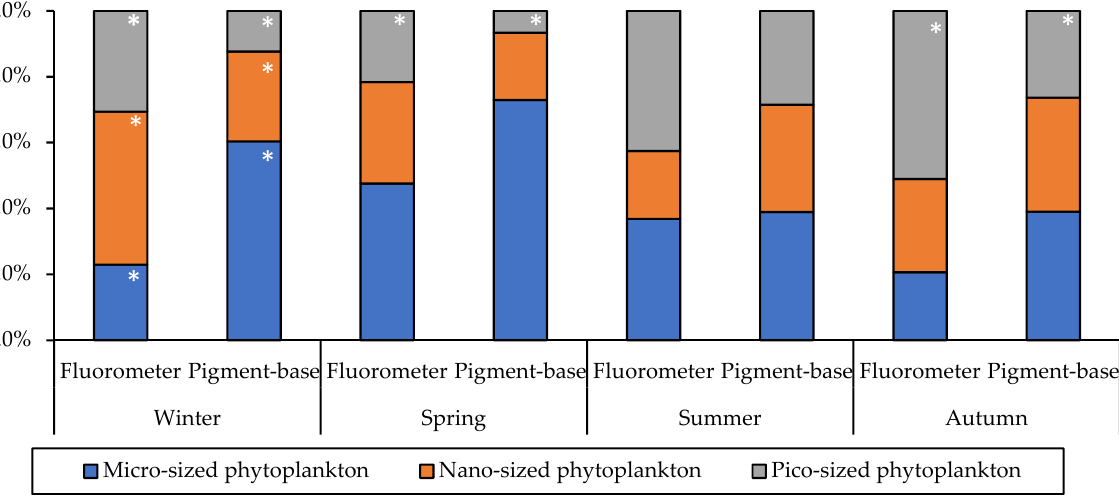
Figure 4. The relative contributions of size-fractionated chlorophyll-a concentrations, as determined by two methods. The white star (*) implies a significant difference at the level of p < 0.05. Previously, Choi [57] found that micro-sized phytoplankton were dominant